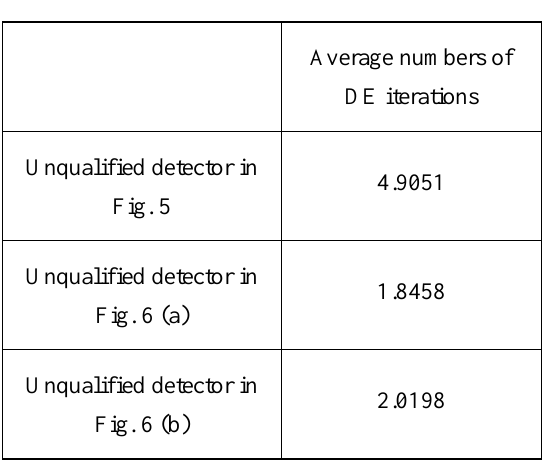
Table 1. Average numbers of DE iterations for update of unqualified detectors.